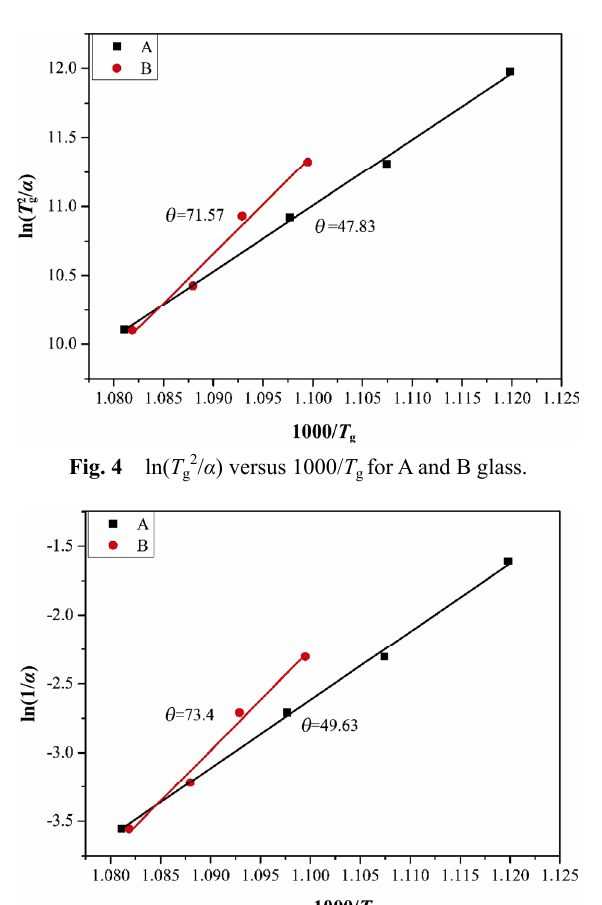
Fig. 3 ln( T p2 / α ) versus 1000/ T p for A and B glass.